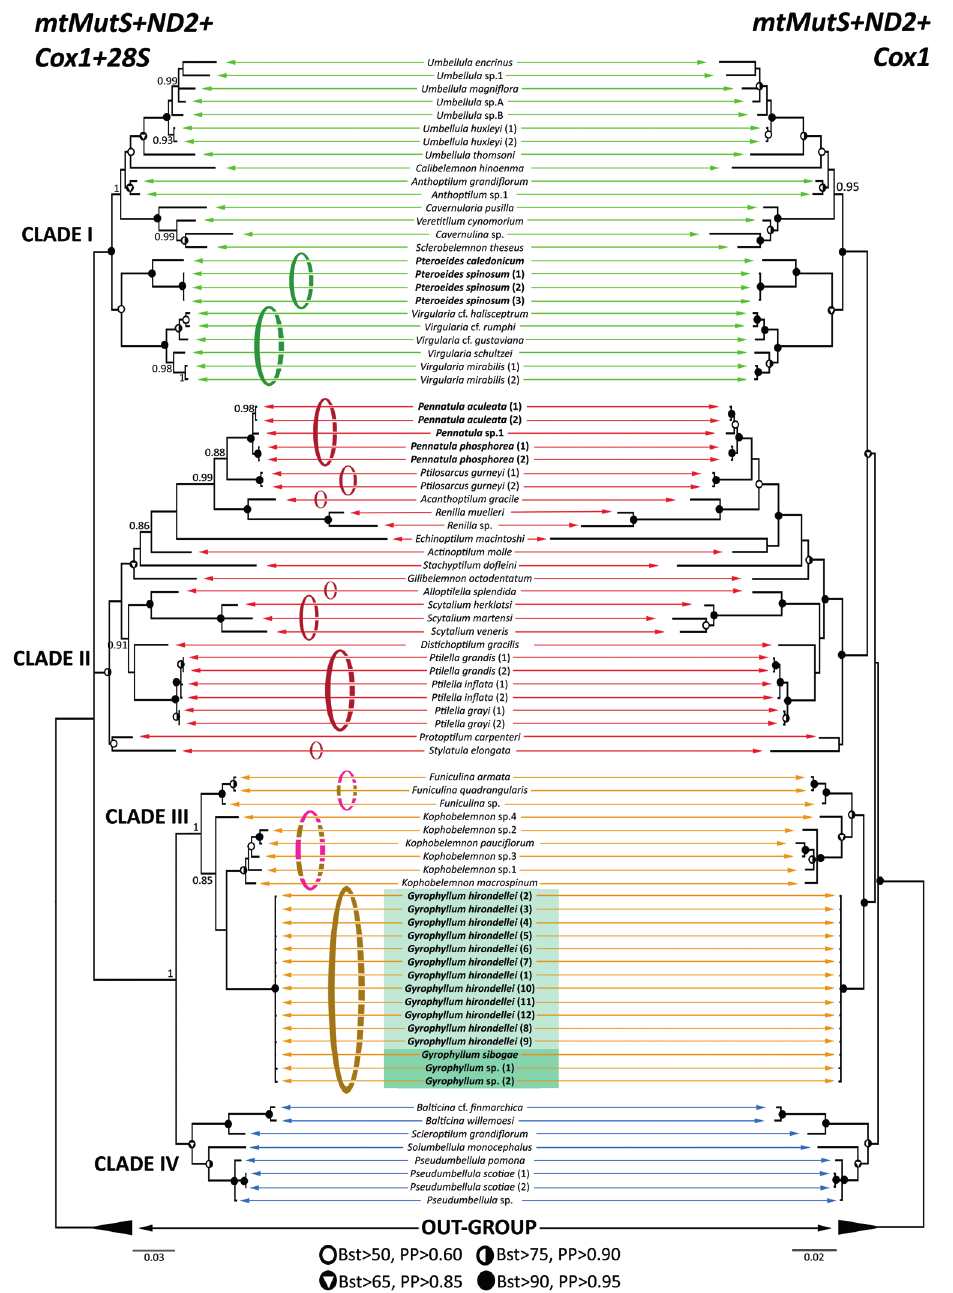
Fig. 2. Bayesian analyses showing the phylogenetic relationships of pennatulacean species (see Table 1) with the four main Clades I–IV indicated by coloured arrows. Sequences of the genus Gyrophyllum are in Clade III (light green are Atlantic specimens, while dark green are Indo-western Pacific specimens). The present hypotheses are based on mtMutS + ND2 + Cox1+28S (left) and the concatenated set of sequences mtMutS + ND2 + Cox1 (right). Only values of Bst >50 and PP >80 have been considered to be codified according legend. When Bst was <50 but PP was >80, PP value is indicated. The trees are drawn to scale, with branch lengths measured in the number of substitutions per site. Numbers in the tree clades represent Posterior Probability values not supported by ML. Yellow rings (continuous or alternate with pink lines) delimit taxa at genus level in Clade III. Rings of continuous lines (regardless of colour) delimit taxa with polyp leaves at genus level in Clades